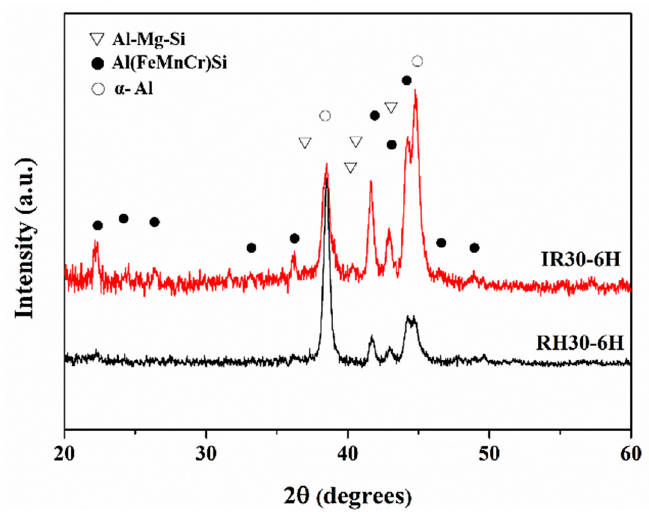
Figure 12. XRD patterns of A6082 alloys treated under various T6 heat treatment conditions.